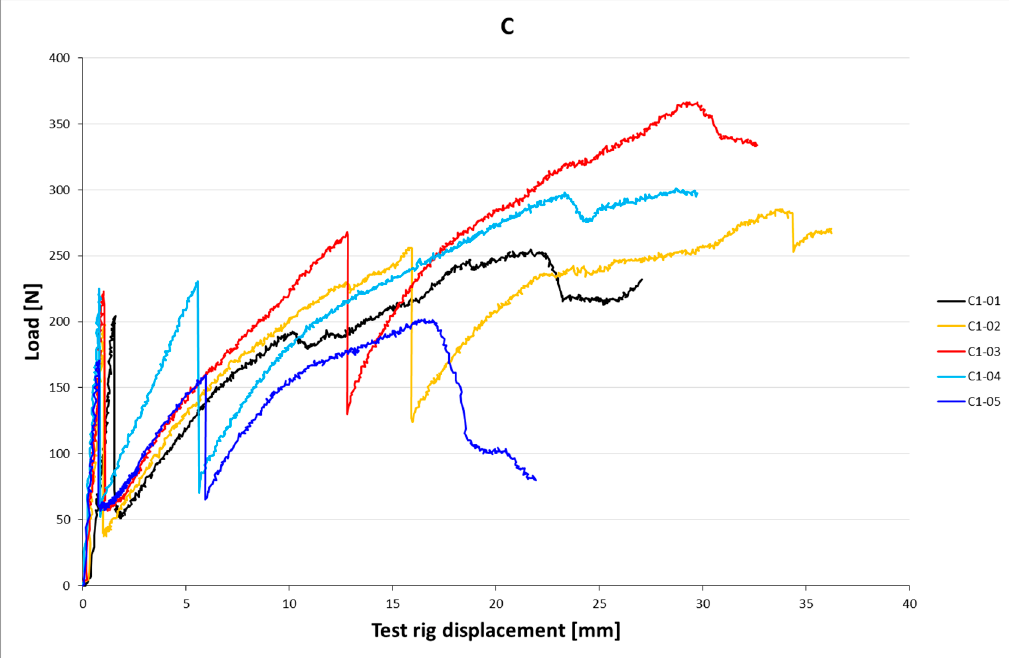
Figure 17. Load-displacement curves of printed beams with C-type cable.